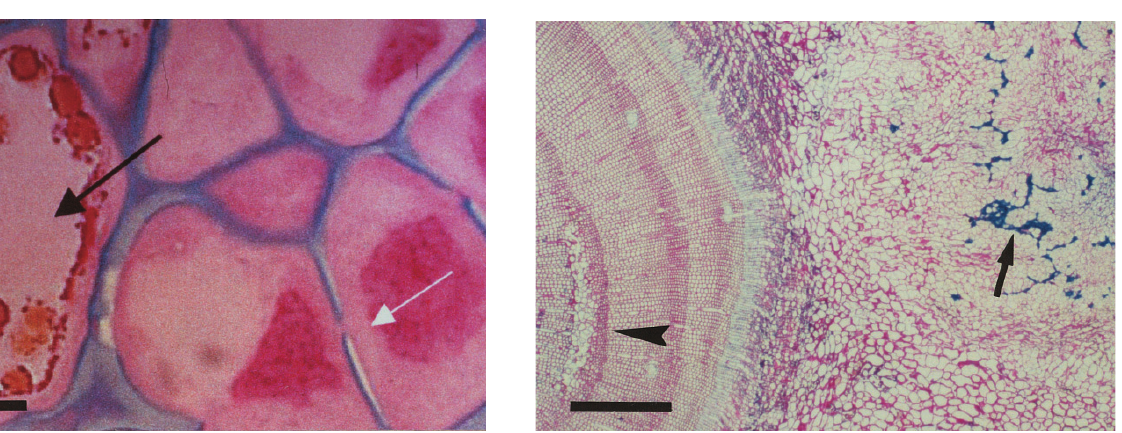
Fig. 7. Cross-section of a 5-year-old Aleppo pine twig with a super fi cial knot. Note the disorganisation of the second-year wood ring (arrow head) and the bacterial zoogloeae in the knot parenchyma (arrow). Bar=500 μ m (fuchsin-Astra blue).